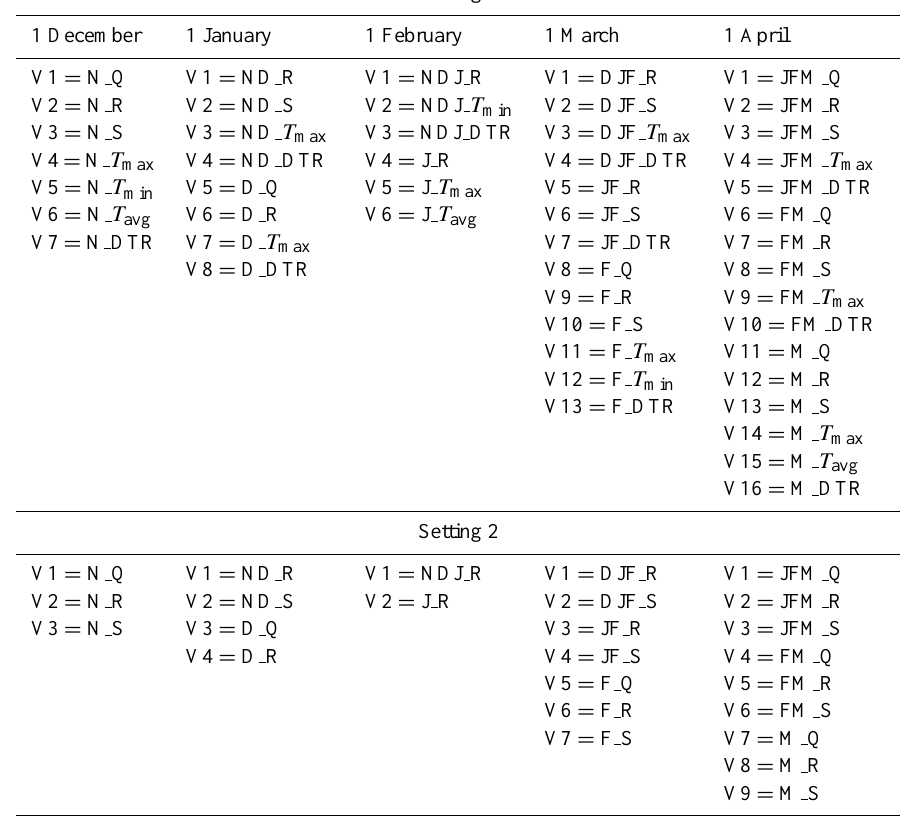
Table 5. Variables selected using bestglm with AIC and the final models at different lead times for setting 1 (combining IMD rainfall and temperature data with BBMB station snow data) and setting 2 (using station rainfall and snow data only as the predictors and omitting temperature).